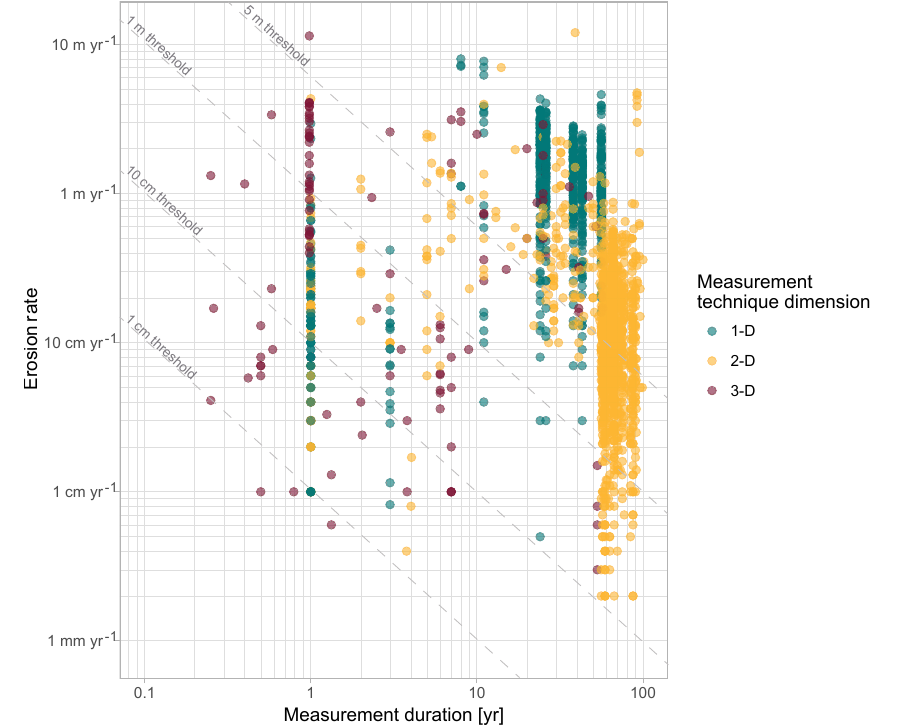
Figure 11. Survey time vs. erosion rate by groups of measurement